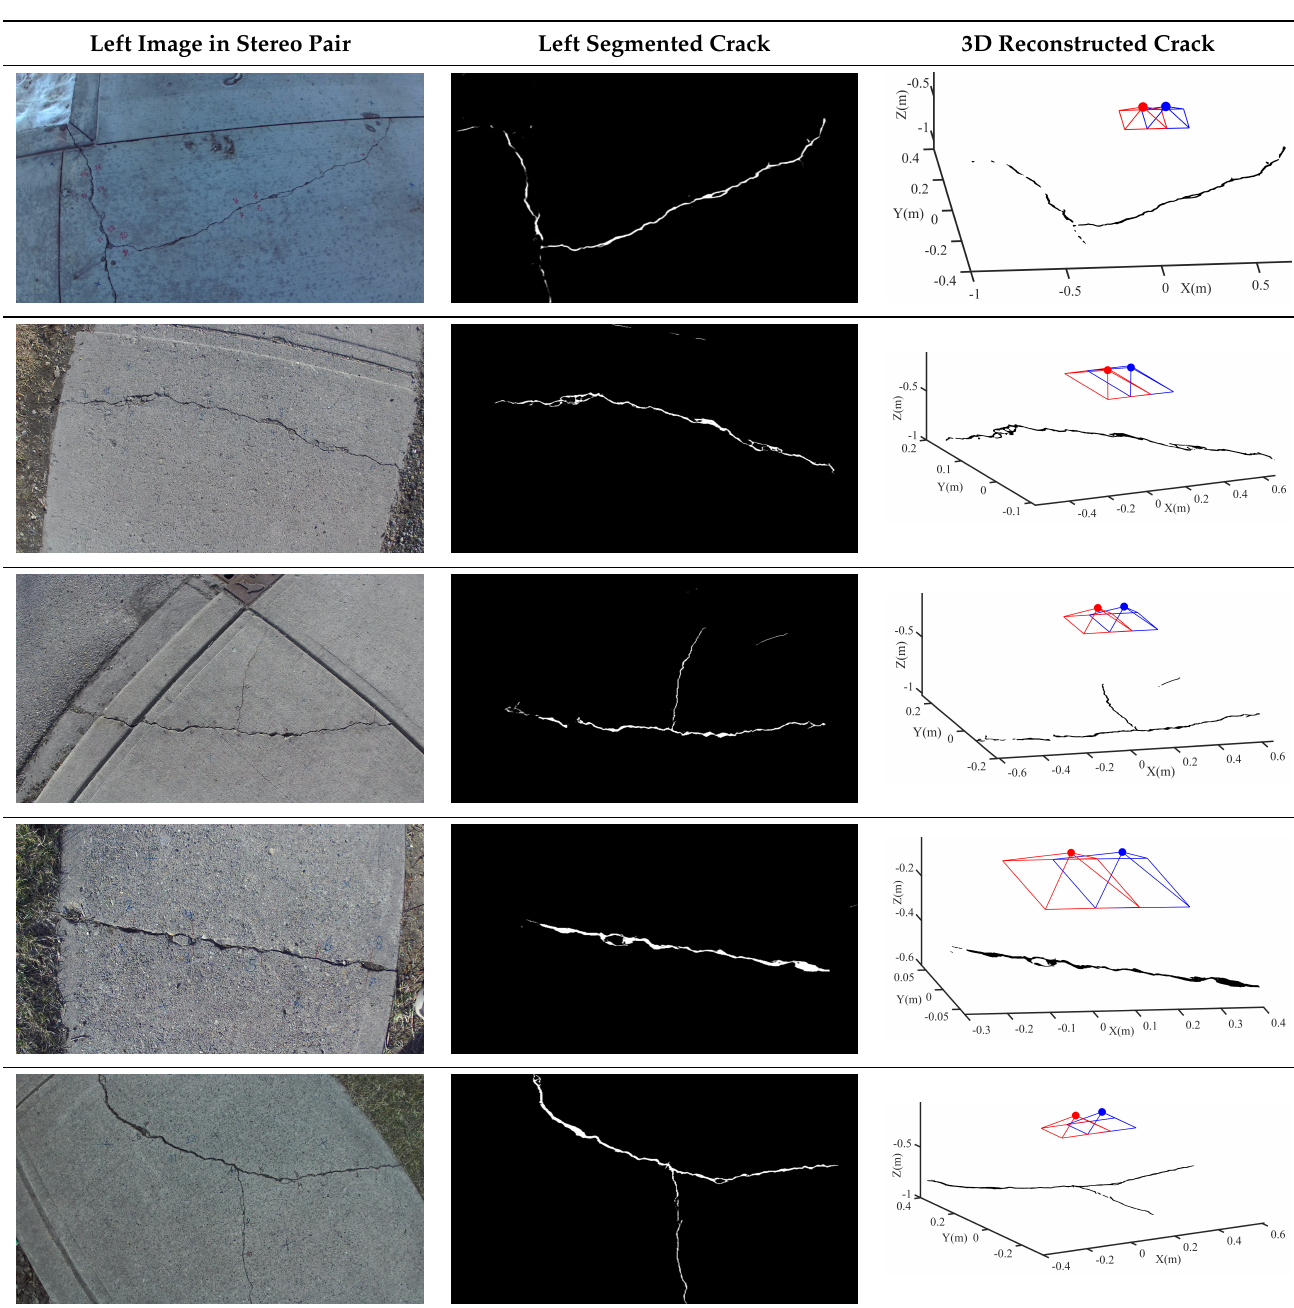
Table A2. Test images, segmented cracks using UNet, and 3D reconstructed cracks using the planar approach. The red and blue pyramids show the left and right camera